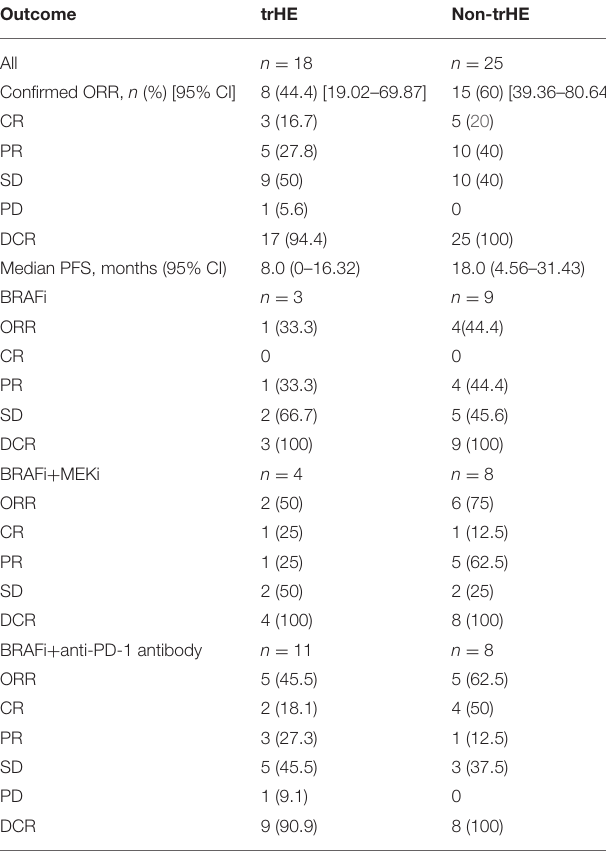
TABLE 5 | Efficacy outcomes.